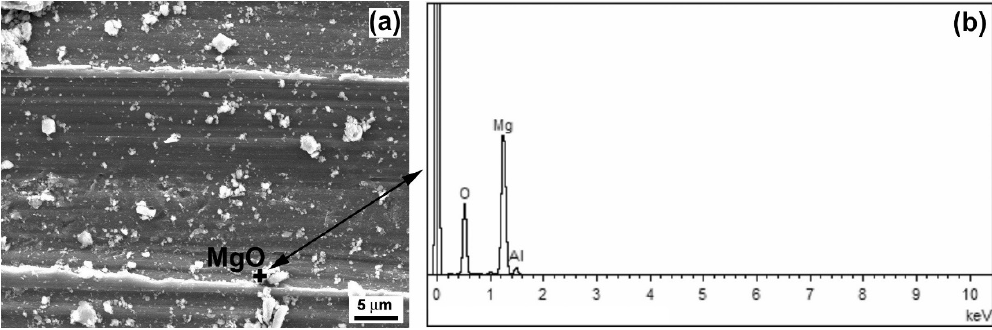
Figure 13. Detailed SEM analysis of the wear track of laser surface remelted AZ61–10 wt.% Al 2 O 3 nanocomposite: ( a ) SEM image depicting the track morphology and ( b ) typical EDX spectrum of selected magnesium oxide.